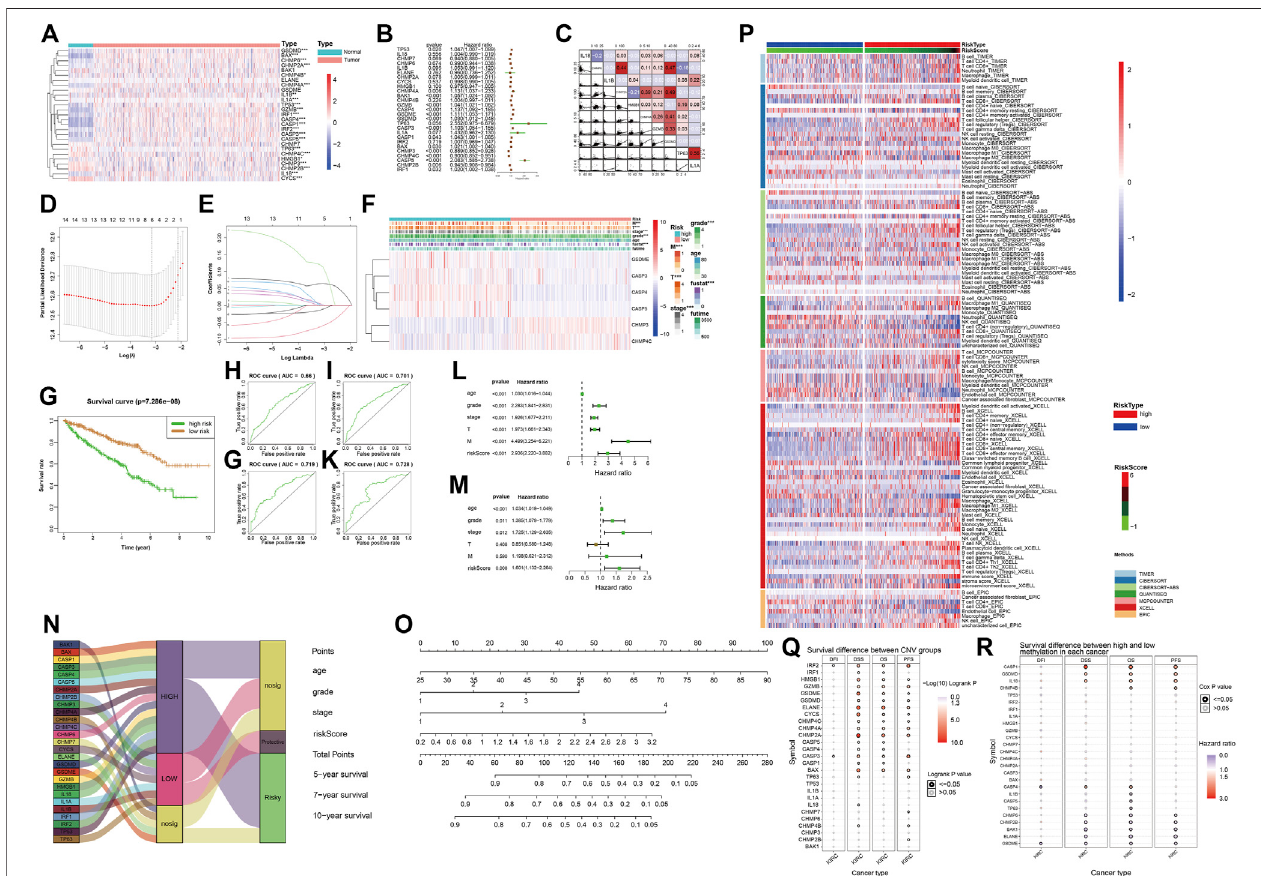
FIGURE5|(A) Theheatmapshowstheexpressionofpyroptosis-relatedgenesinthetumorgroup(pink)andthenormalgroup(lightblue).Thecolorbarontheright indicatesthattheclosertored,themoreup-regulatedtheexpression,theclosertoblue,themoredown-regulatedtheexpression.(*: p < 0.05,**: p < 0.01,***: p < 0.001) (B) The forest map shows the hazard ratio of different pyroptosis-related genes in KIRC. (C) The co-expression relationship between 10 pyroptosis-related genes with signi fi cantstatisticalsigni fi cance,theirregressionrelationshipisdisplayedwithscatterplots,thecorrelationcoef fi cientisrepresentedbycolor,apositivecorrelation is red, a negative correlation is blue, the deeper the color represents the greater correlation. (D – E) Six variables (genes) were screened out by LASSO regression to construct the prediction model. (F) The heatmap shows differences in the expression of the six selected genes and clinicopathological features between the high- and low-risk groups with a risk-score cut-off =0.5. (*: p < 0.05, **: p < 0.01, ***: p < 0.001) (G) Survival curves of high-risk and low-risk groups. (H – K) The ROC curve of survivalprediction at4-time points shows theauthenticityofthe prognostic model, from left toright: toprow: 3 years, 5years, bottom row: 7 years, 10 years. Ingeneral, AUC > 0.7isconsideredtobetrue. (L) UnivariateCoxregressionanalysis. (M) MultivariateCOXregressionanalysis. (N) TheSankeyplotshowstheclassi fi cationofthese pyroptosis-related genes after our analysis: the level of expression in KIRC tumor tissues and the role of cancer suppressor or carcinogenic in KIRC. (O) The nomogram oftheprognosticmodel. (P) Heatmapforimmuneresponsesbasedondifferentalgorithmsamongthehigh-andlow-riskgroups.Differentalgorithmsarerepresentedby different colored area bars. (Q) Correlation between CNV mutations of different pyroptosis-related genes and survival coef fi cient in KIRC. (R) Correlation